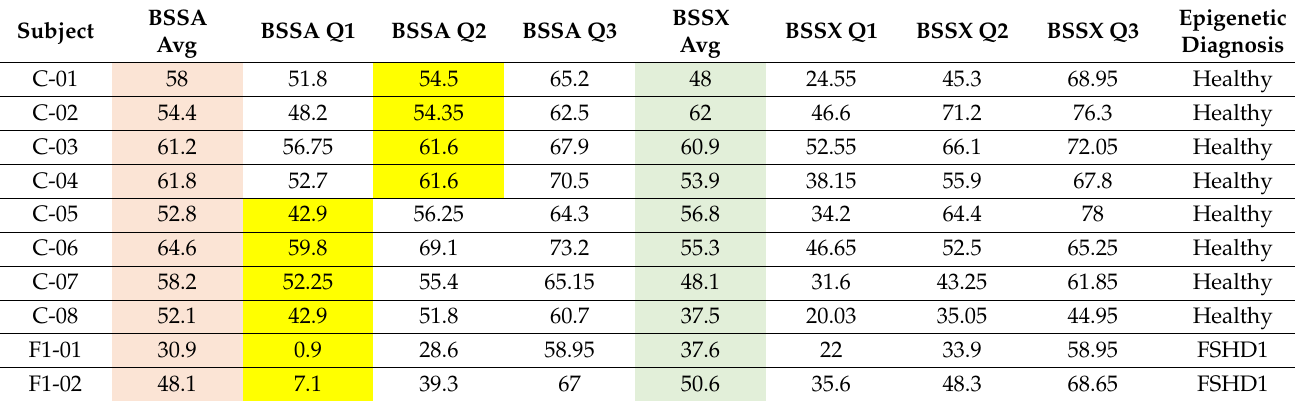
Figure 4. BSS analysis comparison of FSHD2 epigenetic signatures. BS-converted DNA from a genetically confirmed FSHD2 subject (F2-02) was analyzed using BSSA, BSSX, BIS-5 (cid:48) , BIS-Mid, and BIS-3 (cid:48) assays. Each BS graphic representation is shown approximately where it aligns with each part of the 4q35 D4Z4 array including the D4Z4 (orange), DUX4-fl ORF (green), DUX4 Intron 1, Exon 2, Intron 2 (purple), and Exon 3 (pink), with exact location indicated by base pairs (bp) downstream from the Kpn I site of the distal D4Z4 RU. Blue boxes indicate unmethylated CpGs, red boxes indicate methylated CpGs, and white boxes indicate no CpG where one is expected. Average methylation percentages are denoted “Avg” and have values of 15.2% for BSSX, 51.3% for BIS-5 (cid:48) , 61.9% for BIS-Mid, 61.2% for BIS-3 (cid:48) , and 13.1% for BSSA. This FSHD2 subject has a haplotype of 4A161/4B163. Therefore, the diagnostic methylation percentages of the second quartile (Q2) are included for BSSA (10.7%) and BIS-3 (cid:48) (70%) for comparison. Table 2. Results of epigenetic analysis using the Jones et al.